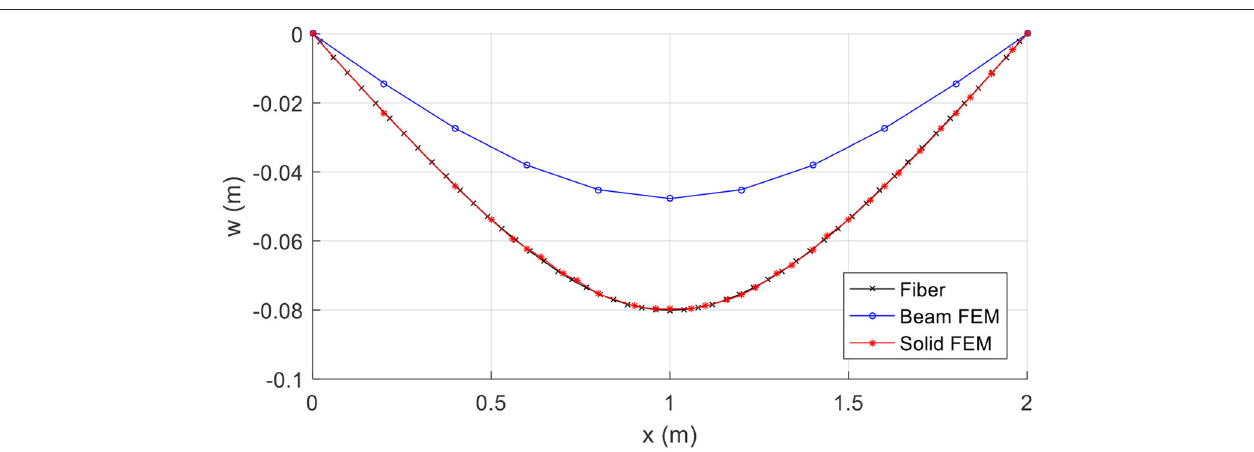
FIGURE 10 | Profile of deflections for p z = 4541.42kN/m in Example 2.